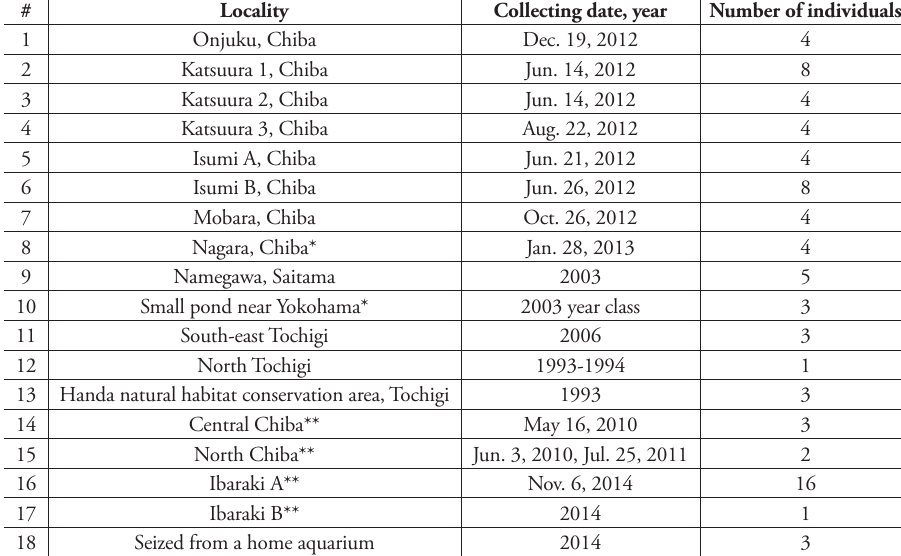
Table 1. Localities and specimens used in this study.